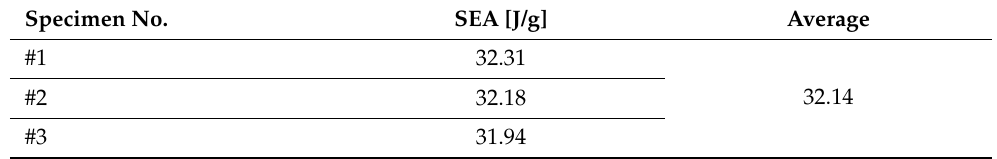
Table 2. SEA values of flat-plate specimens.